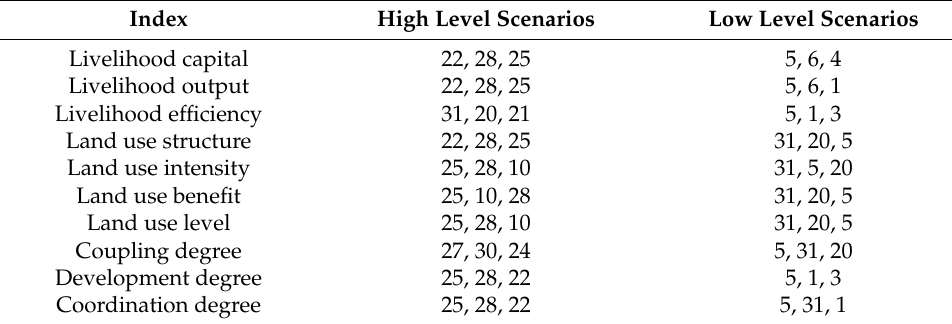
Table 7. High level scenario and low level scenario of each